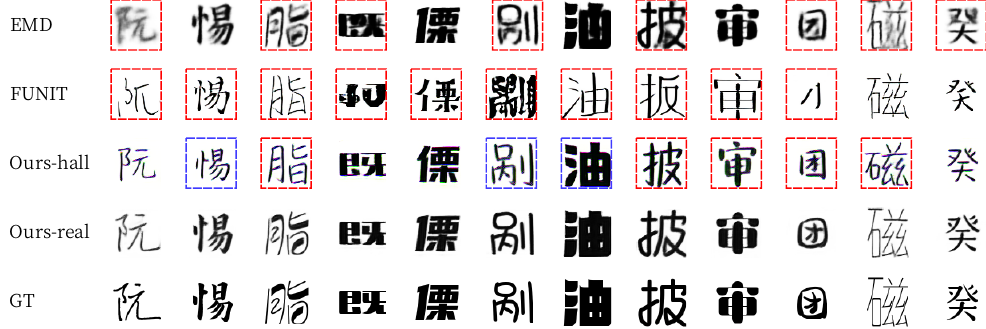
Figure 13. Examples of Chinese seen font style generation. Red boxes represent ‘bad’ results, blue boxes ‘not bad’, and no box ‘good’ result.